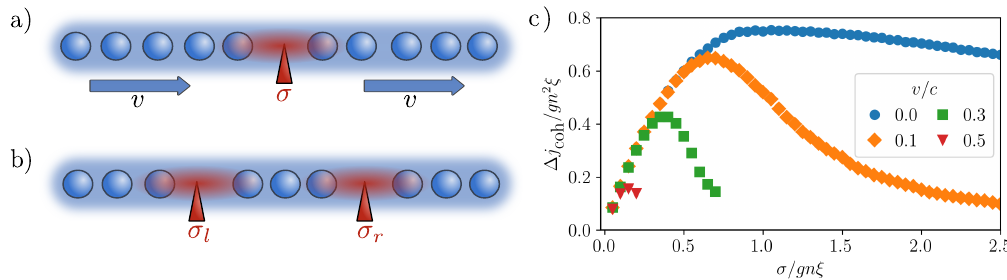
Figure 1: Scheme for controlling superfluid flow in a one dimensional interacting Bose gas using one a) or two b) noisy impurities, with or without an external current at velocity v . c) Induced superfluid current at a noisy point contact of noise strength σ in a moving condensate at velocity v . For weak noise the current grows monotonically with σ , but for stronger noise the system enters a Zeno regime, where the current decreases. For the two largest velocities the system enters a regime of dynamical instabilities beyond a certain value of σ , where the current is no longer stationary and thus not